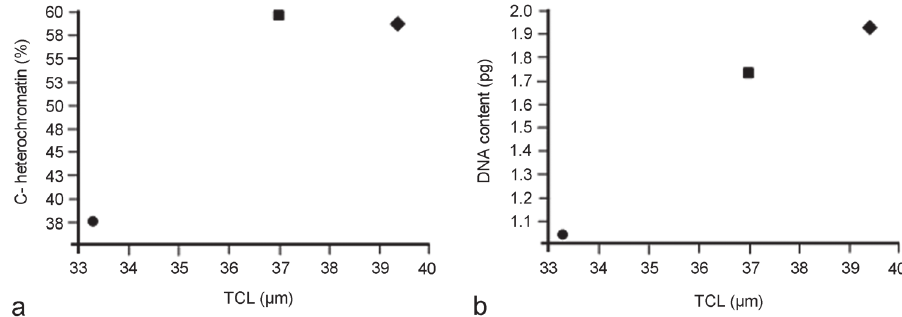
Figure 6. a Comparison between the total chromosome length (TCL) and the percentage of C-positive heterochromatin at diakinesis in B. dentatum (58.54 ± 1.27 %; circle), B. elongatum (59.47 ± 0.78 %; rectangle) and B. gestroi (37.24 ± 1.50 %; diamond) b Comparison between the total chromosome length (TCL) and the haploid DNA content (pg) in B. dentatum (1.93 ± 0.16 µm; circle), B. elongatum (1.75 ± 0.05 µm; rectangle) and B. gestroi (1.13 ± 0.13 µm; diamond). Data of percentage of C-positive hetero- chromatin and the haploid DNA content were obtained from Papeschi (1991,